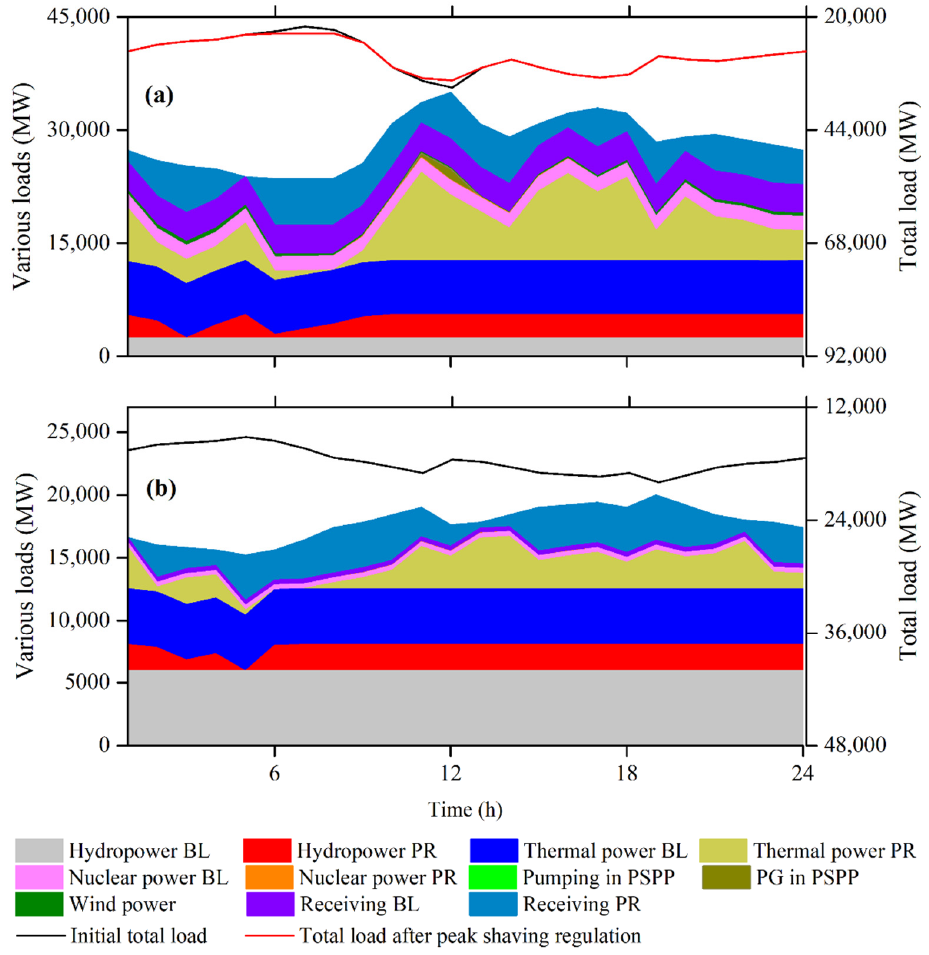
Figure 7. Diurnal dynamic of various loads under the power balance condition in the optimal equilibrium solution for ( a ) GdPG and ( b ) GxPG as sending-ends of the grid-connected hybrid energy system.